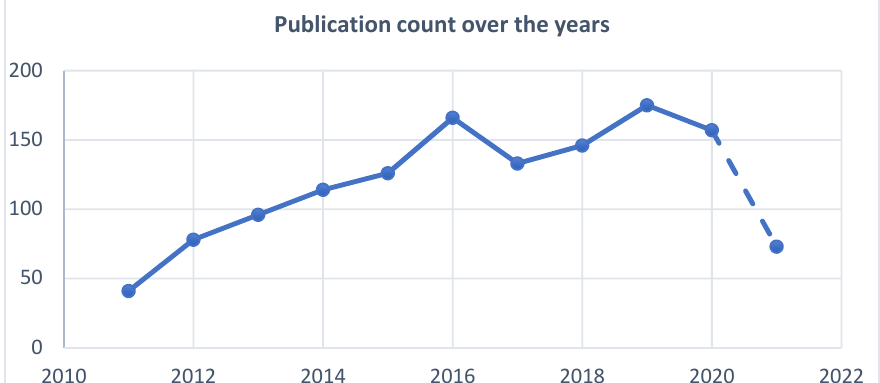
Figure 4. Publication count over the years.